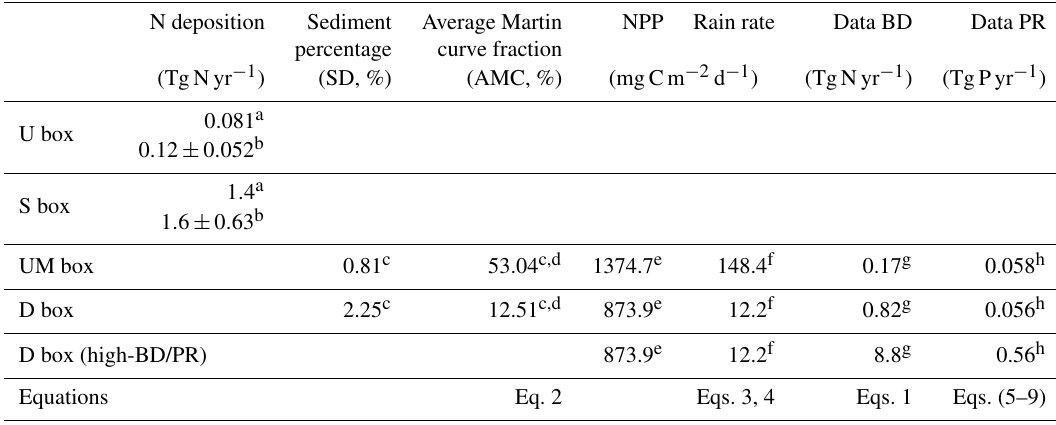
Table 2. Summary of data-based flux estimates. “N deposition” is the annual nitrogen input via atmospheric deposition; “Sediment percent- age” is the percentage of the surface areas of the UM and D boxes in contact with the sediment; “Average Martin curve fraction” represents the average fractions (calculated from the Martin curve) of export production reaching the sediment for each grid point of the topography data; “NPP” is the net primary production estimated from Aqua-MODIS satellite data; “Data BD” and “Data PR” represent fixed-N loss via benthic denitrification and phosphate release via phosphorus regeneration in the UM and D boxes, respectively. High-BD indicates that the full sediment of the D box is included to estimate NO − loss via benthic denitrification and phosphate release via phosphorus regeneration. 3